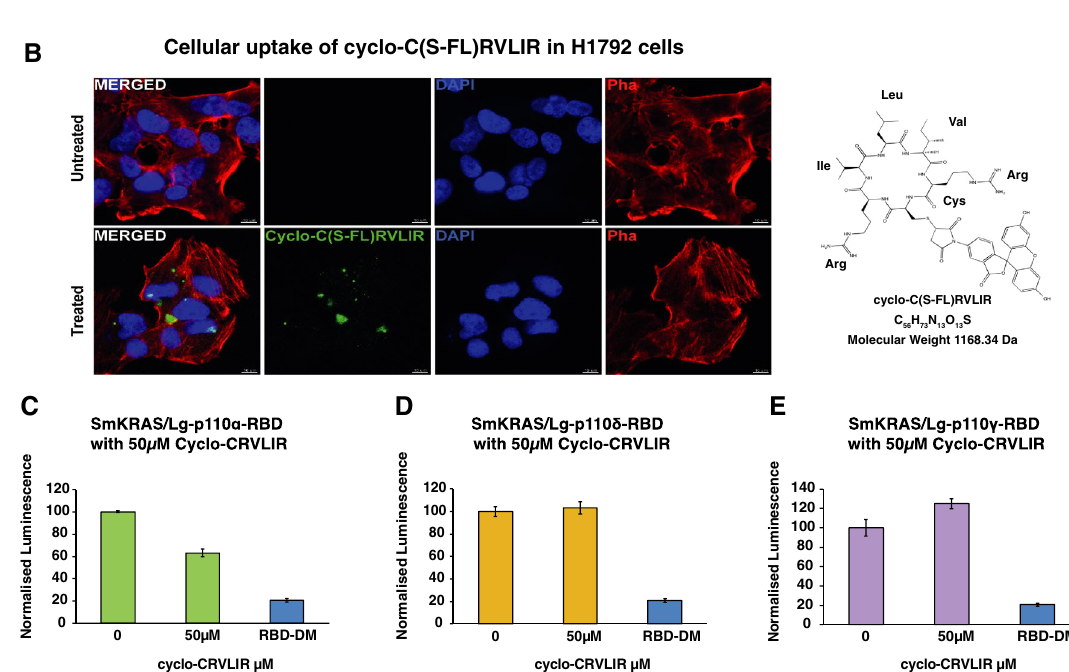
Figure 3. Analysis of the effect of cyclo-CRVLIR in cancer cell lines and NBBA. ( A ) H1792 and H1373 cells were treated with increasing concentrations of cyclo-CRVLIR (4, 20 and 100 µM) for 4 h. Cell lysates were probed with the indicated antibodies. Bottom graphs show expression of phospho-AKT (anti-pAKT-S473) and total AKT (normalised to calnexin expression). Mean ± SEM, N = 3, un-paired Student’s t-test treated vs untreated cells. Original blots with multiple exposure times are presented in Supplementary Fig. 6 with the main blot presented in Fig. 3A red box. ( B ) Cellular uptake of the fluorescein-conjugated cyclo-C(S-FL)RVLIR in H1792 cells. Representative images of H1792 cells, stained for DAPI (blue) and Phalloidin (red), after treatment with 100 μM of the peptide (green) for 24 h, on the right is the structure of the fluorescein-conjugated C(S-FL)RVLIR. ( C – E ) Testing the specificity of Cyclo-CRVLIR to RBDα using the NBBA. The three RAS binding domains of PI3K isoforms (Lg-RBDα, Lg-RBD δ and Lg-RBDγ) were transfected with Sm-KRAS in HEK293 cells, and cell lysates were treated with 50 µM cyclo-CRVLIR. Only Sm-KRAS/ Lg-RBDα showed reduction in the interaction signal and not the other RBDs, demonstrating that cyclo-CRVLIR is an RBDα specific peptide. RBD-DM (a p110α-RBD with two mutations, T208D and K227A, that does not bind to RAS) was cloned and expressed in the Lg-BiT (Lg-RBD-DM). In the control experiments, Sm-KRAS-G12C was co-transfected with Lg-RBD-DM and the lysate was used as a negative control to indicate the true signal reduction upon the inhibition of the RAS/p110α